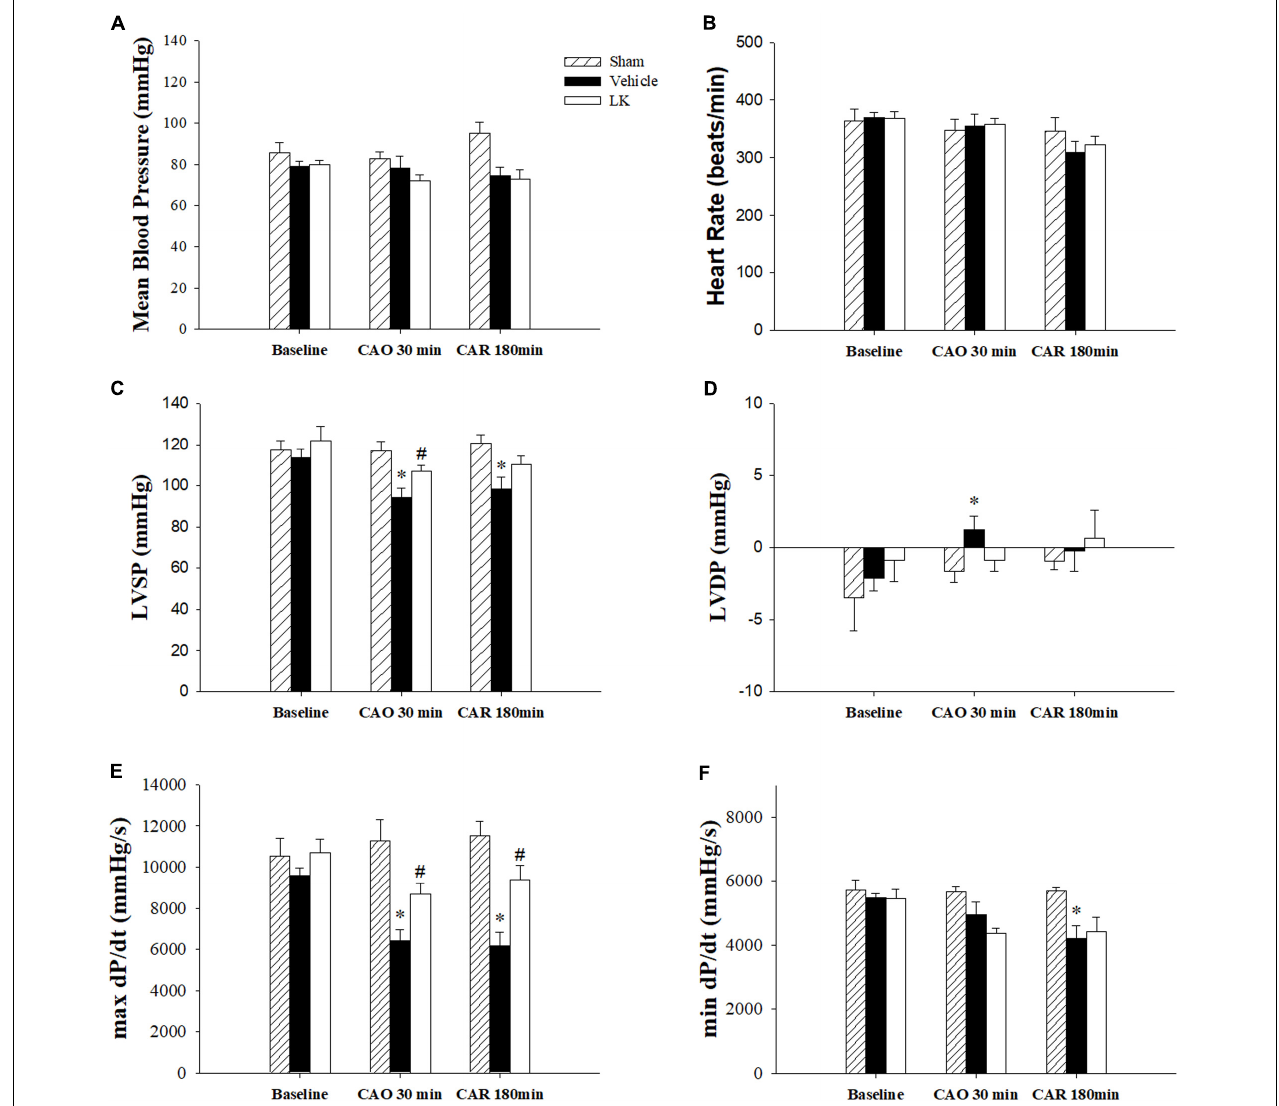
FIGURE 1 | Cardiac function parameters in I-R rats treated with vehicle or lumbrokinase. Post-ischemic treatment with vehicle or lumbrokinase (10 µ g/kg) in rats subjected to myocardial I-R injury. (A) Mean blood pressure, (B) heart rate, (C) LVSP, (D) LVDP, (E) max dP/dt, and (F) min dP/dt were determined before CAO (baseline), 30 min after CAO (CAO 30 min), and 180 min after reperfusion (CAR 180 min). Each value is represented as the mean ± SEM ( n = 4–8). ∗ p < 0.05 compared with the sham group; # p < 0.05 compared with the vehicle group.